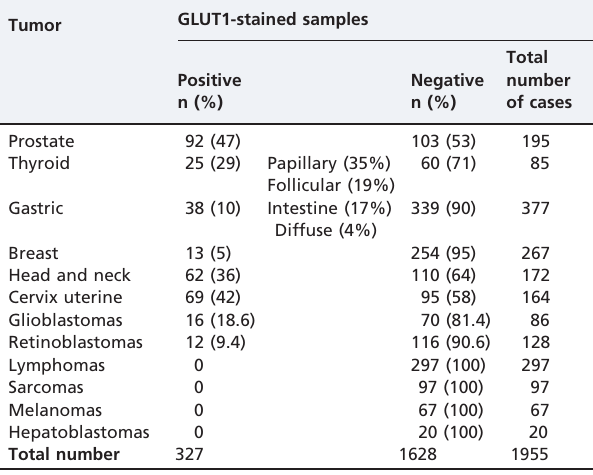
Table 1 - Samples evaluated by immunohistochemistry. Primary site, histological type and number (percentage) of positive and negative samples are